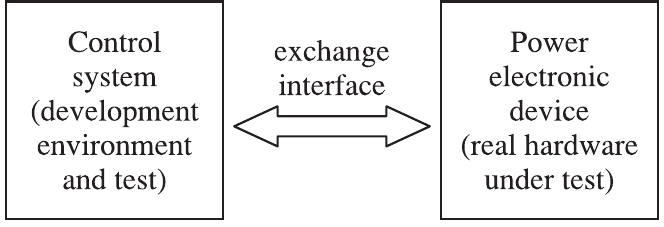
Figure 1. HIL architecture in papers [7,8].